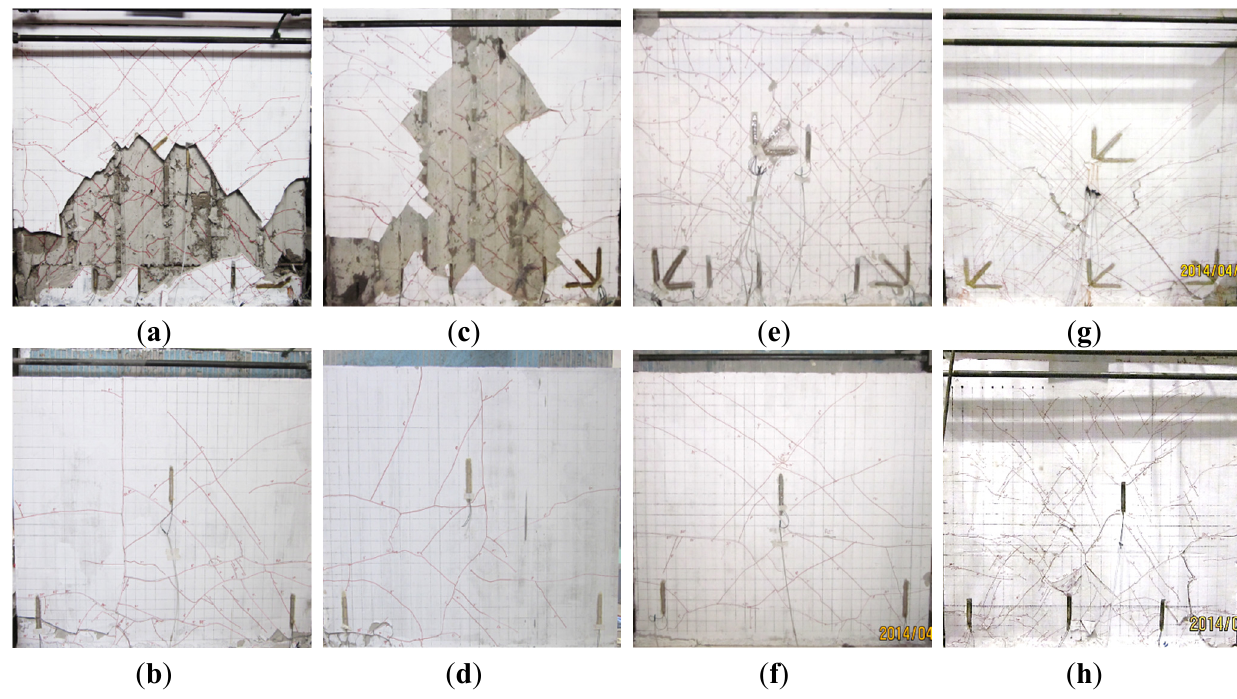
Figure 9. Failure of specimen. ( a ) E-1 (Front); ( b ) E-1(Back); ( c ) E-2 (Front); ( d ) E-2 (Back); ( e ) E-3(Front); ( f ) E-3 (Back); ( g ) I-2 (Front); ( h ) I-2